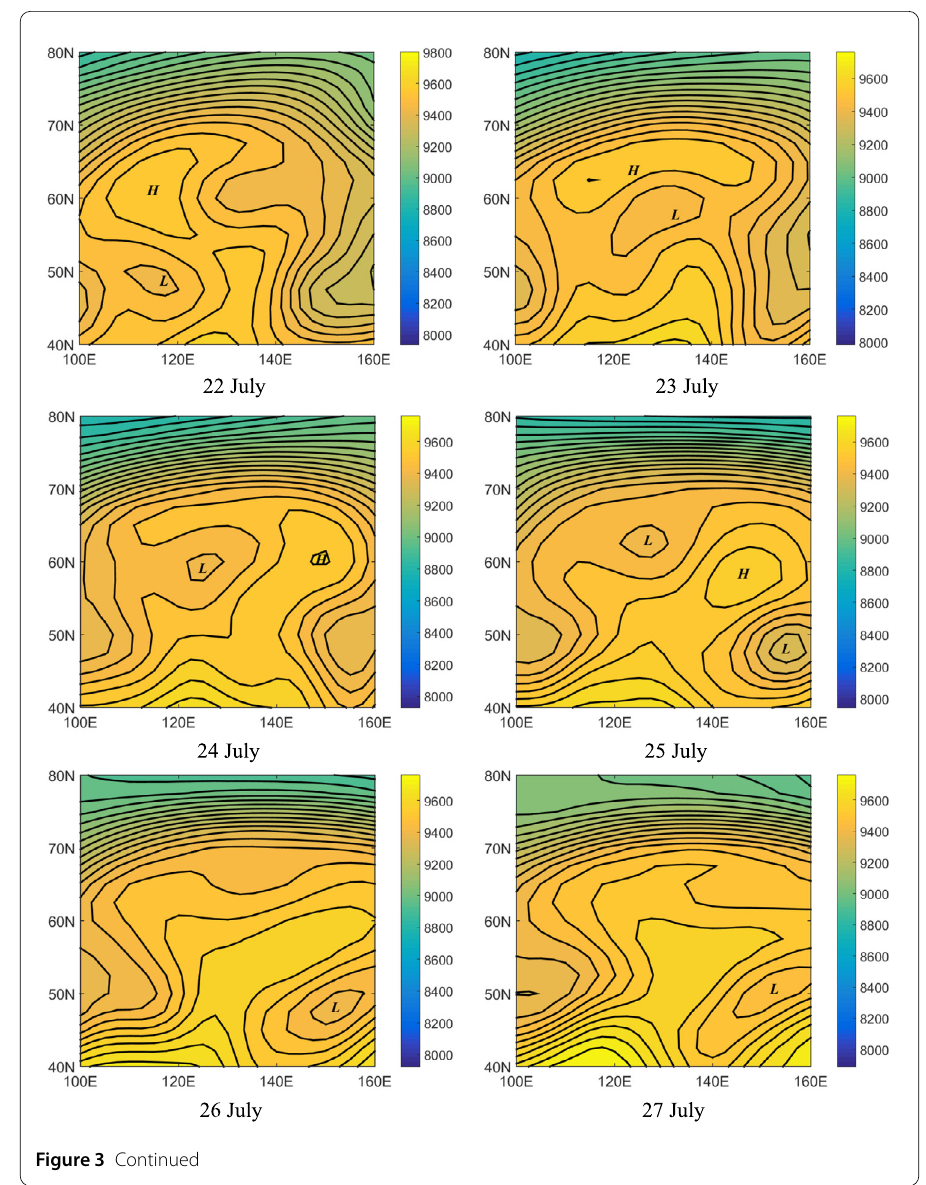
Figure 1 and Fig. 2 reveal the complexity of dipole blocking evolution. However, Fig. 2 basically corresponds well to the real observational blocking case (Fig. 3), although they have different life cycles, they have the same developing process, namely from dipole to multi-pole, then to dipole. Consequently, the introduction of a time-dependent vari- able coefficient topographic forcing term is more suitable to explain the complicated blocking phenomenon. Besides, we suspect that the real blocking process is very com- plicated and changeable, may be accompanied by monopole, dipole, and multi-pole three